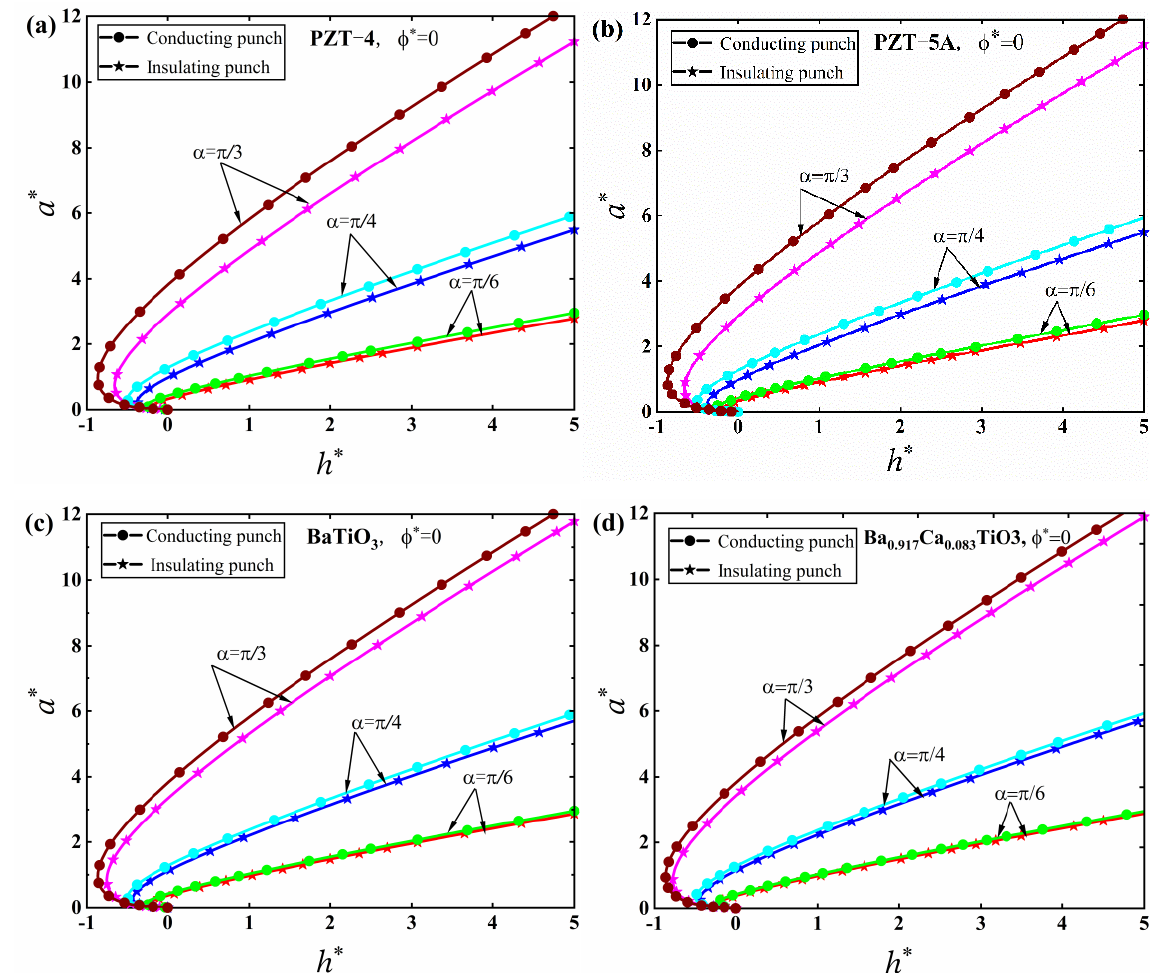
/ 3  for the conducting punch with